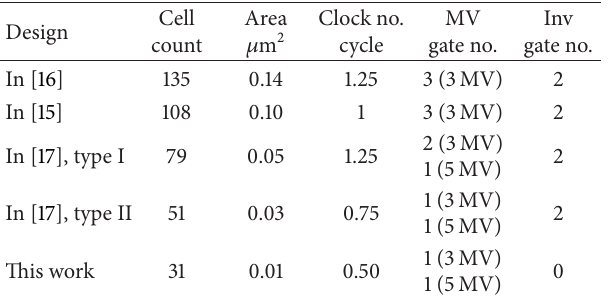
Table 3: Permissible cell displacement of the proposed full